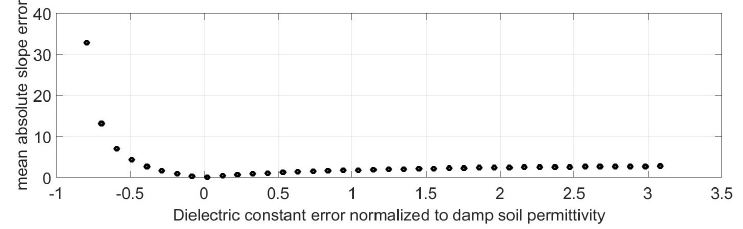
Figure 6. Mean value of the absolute range slope error (in degree) in the damp soil region before azimuth filtering as a function of the dielectric constant normalized to the permittivity of damp soil in the case of correct